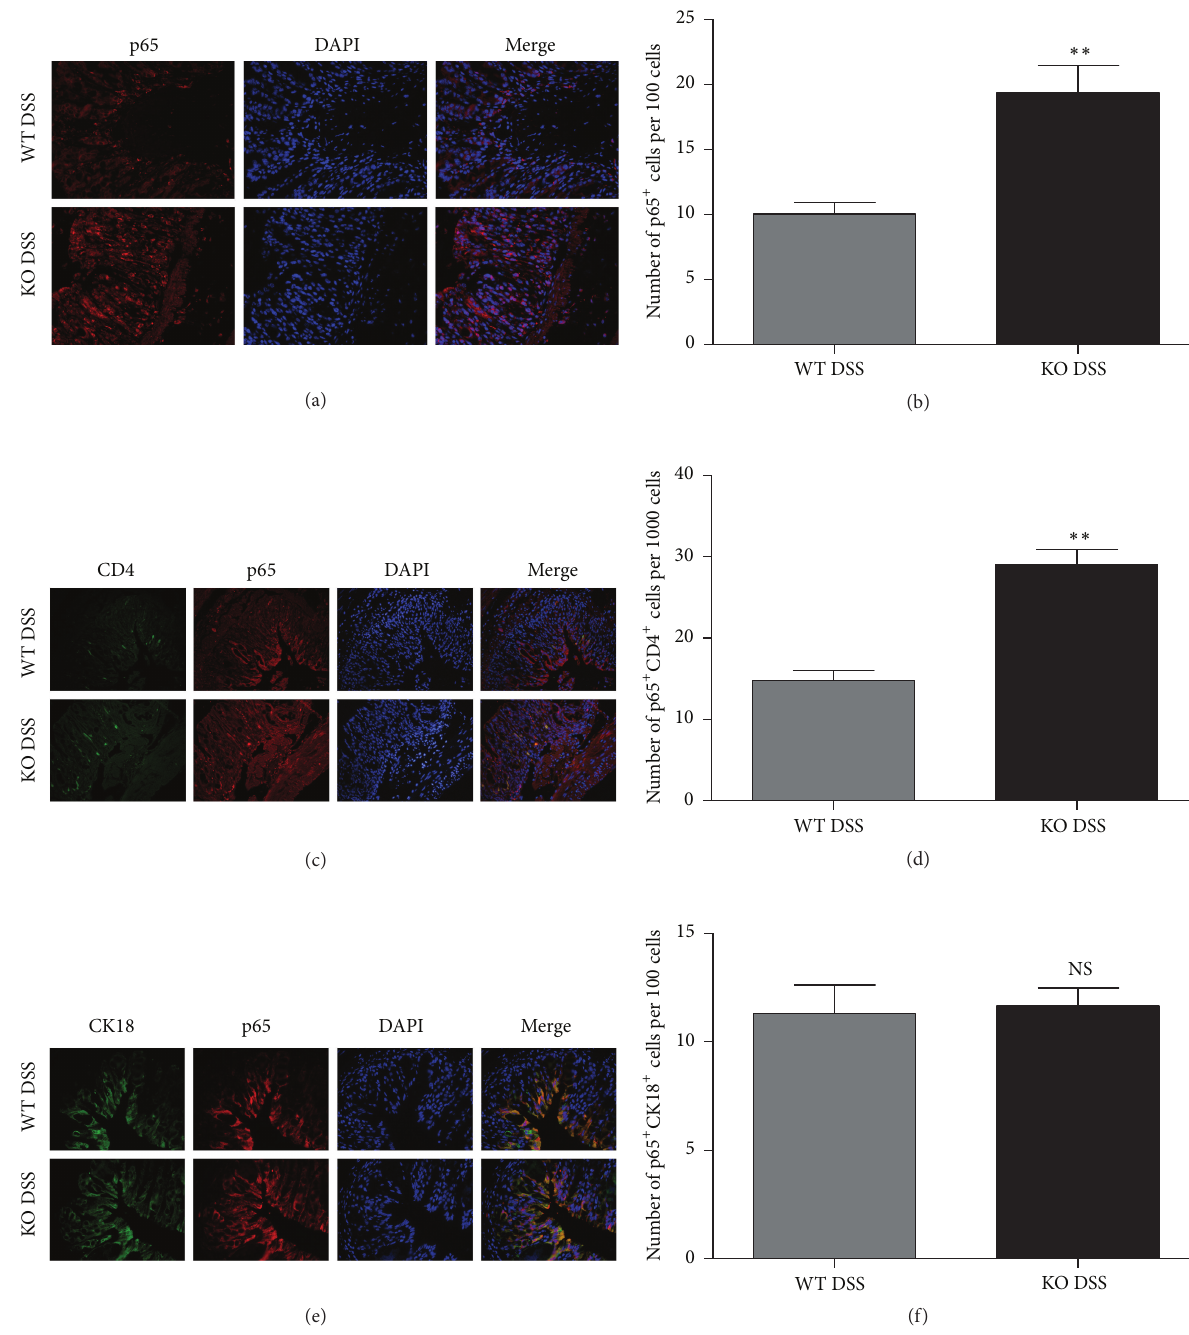
Figure 7: TRAF5 deficiency significantly enhances the activation of p65 in CD4 + T cells after the administration of DSS. (a) Representative immunofluorescence staining for p65. The p65-labeled cells show red fluorescence, and the nuclei show blue fluorescence (magnification 400x). (b) Quantification of p65 positive cells. (c) Representative immunofluorescence staining for CD4 and p65. The CD4-labeled cells show green fluorescence, p65-labeled cells show red fluorescence, and the nuclei show blue fluorescence (magnification 400x). (d) Quantification of p65 + CD4 + cells. (e) Representative immunofluorescence staining for CK18 and p65. The CK18-labeled cells show green fluorescence, p65- labeled cells show red fluorescence, and the nuclei show blue fluorescence (magnification 400x). (f) Quantification of p65 + CK18 + cells. The data are representative of 3 independent experiments (mean ± SD). 𝑁 = 4 per group. ∗∗ 𝑝 < 0.01 versus the DSS-treated WT group. NS: not significant versus the DSS-treated WT